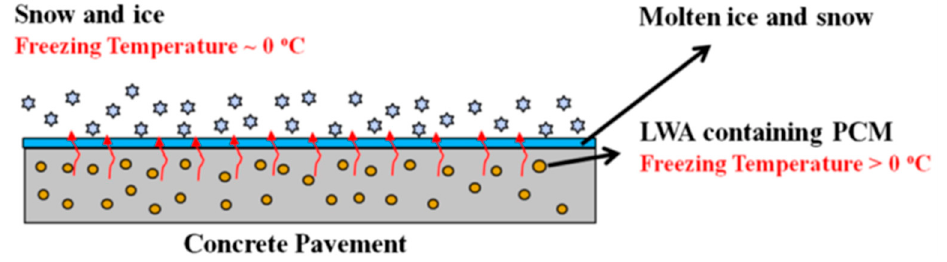
Figure 8. Schematic of using PCM in concrete pavement to melt ice and snow using lightweight aggregate (LWA) [123].